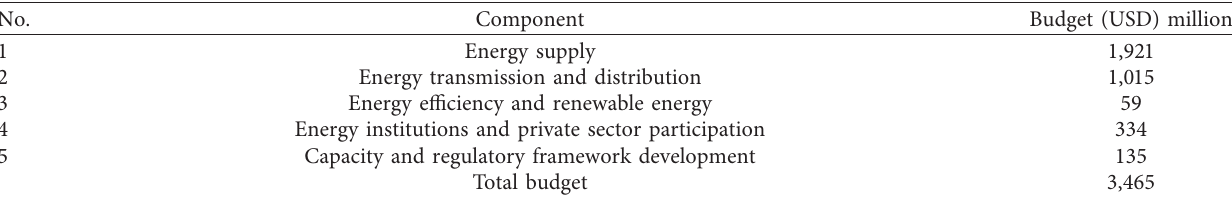
Table 5: NESP components and estimated budget [27].